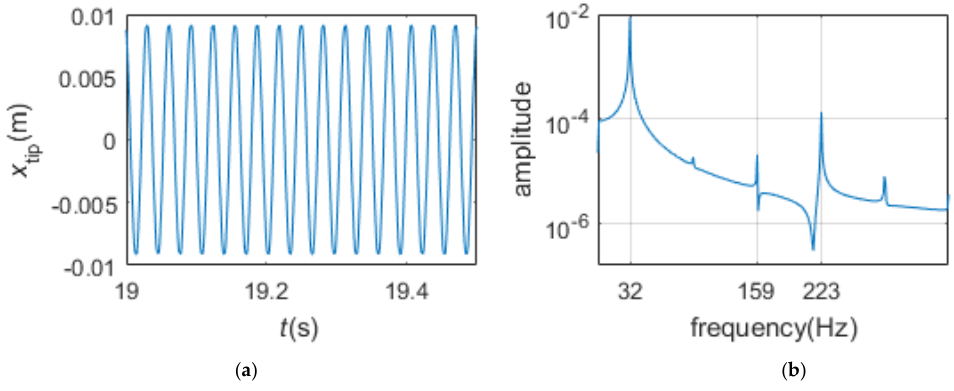
Figure 12. ( a ) The steady-state response of the blade tip; ( b ) the frequency spectrum of the blade tip.